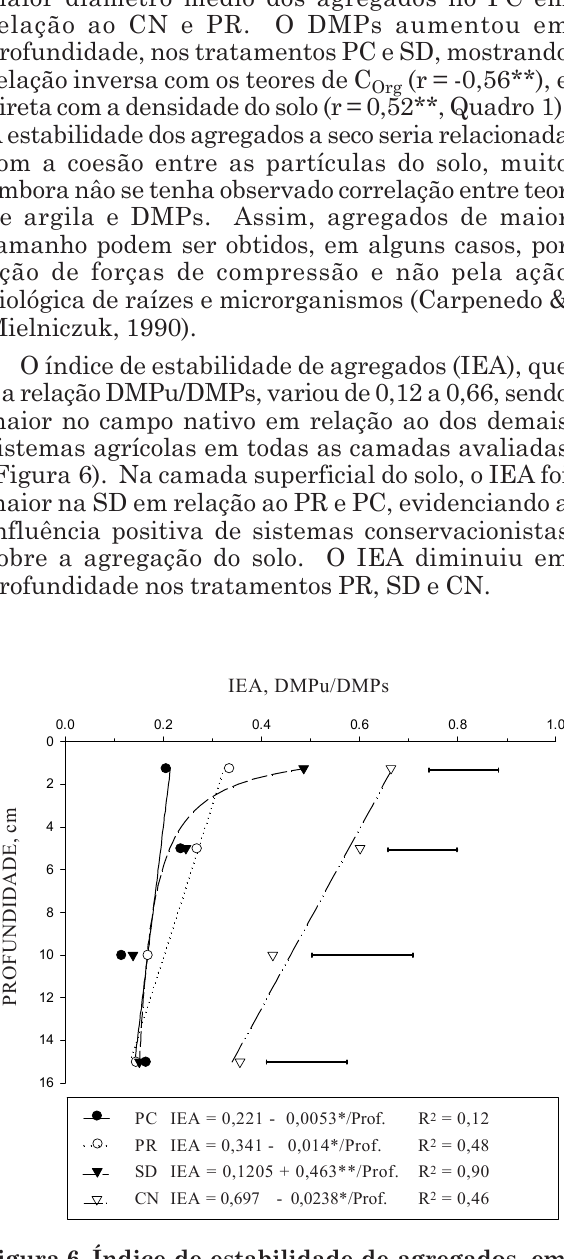
Figura 6. Índice de estabilidade de agregados, em diferentes profundidades, sob diferentes sistemas de manejo. Os pontos representam as médias dos tratamentos (n = 3). As barras horizontais indicam diferenças mínimas significativas entre tratamentos em uma mesma profundidade, calculadas pelo teste de